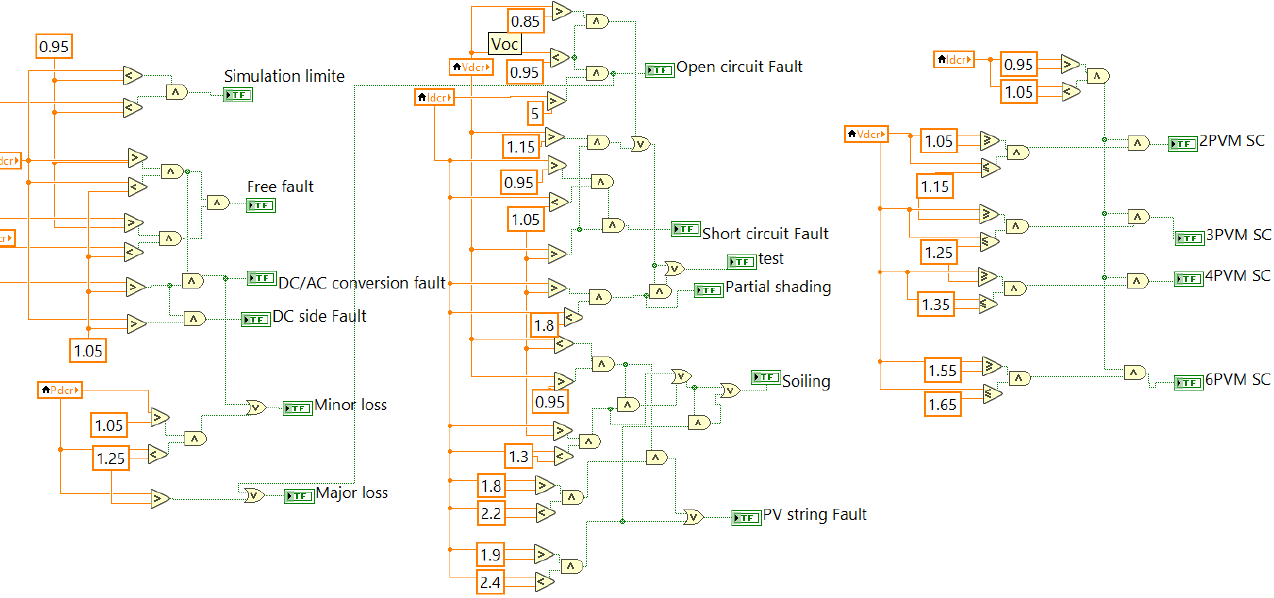
Figure 20. Fault detection and identification program based on the Boolean function under LabVIEW environment.